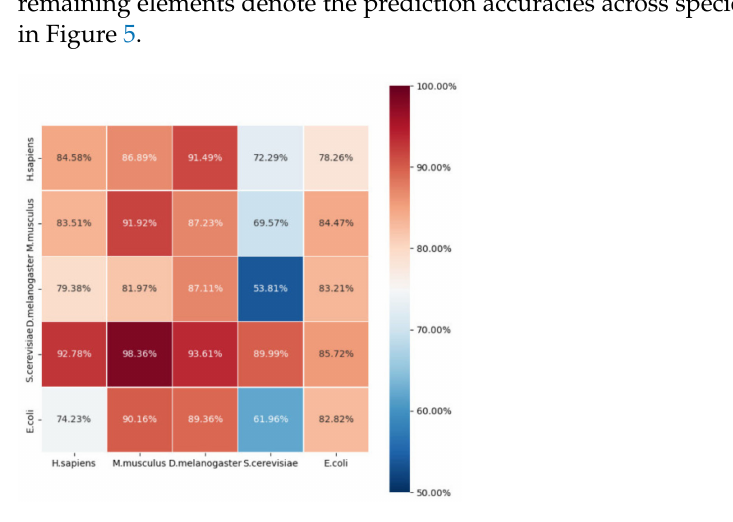
Figure 5. The heat map showing the species prediction accuracies (Acc values). The sample of species in the row was used to train, while the sample of species in the column served as